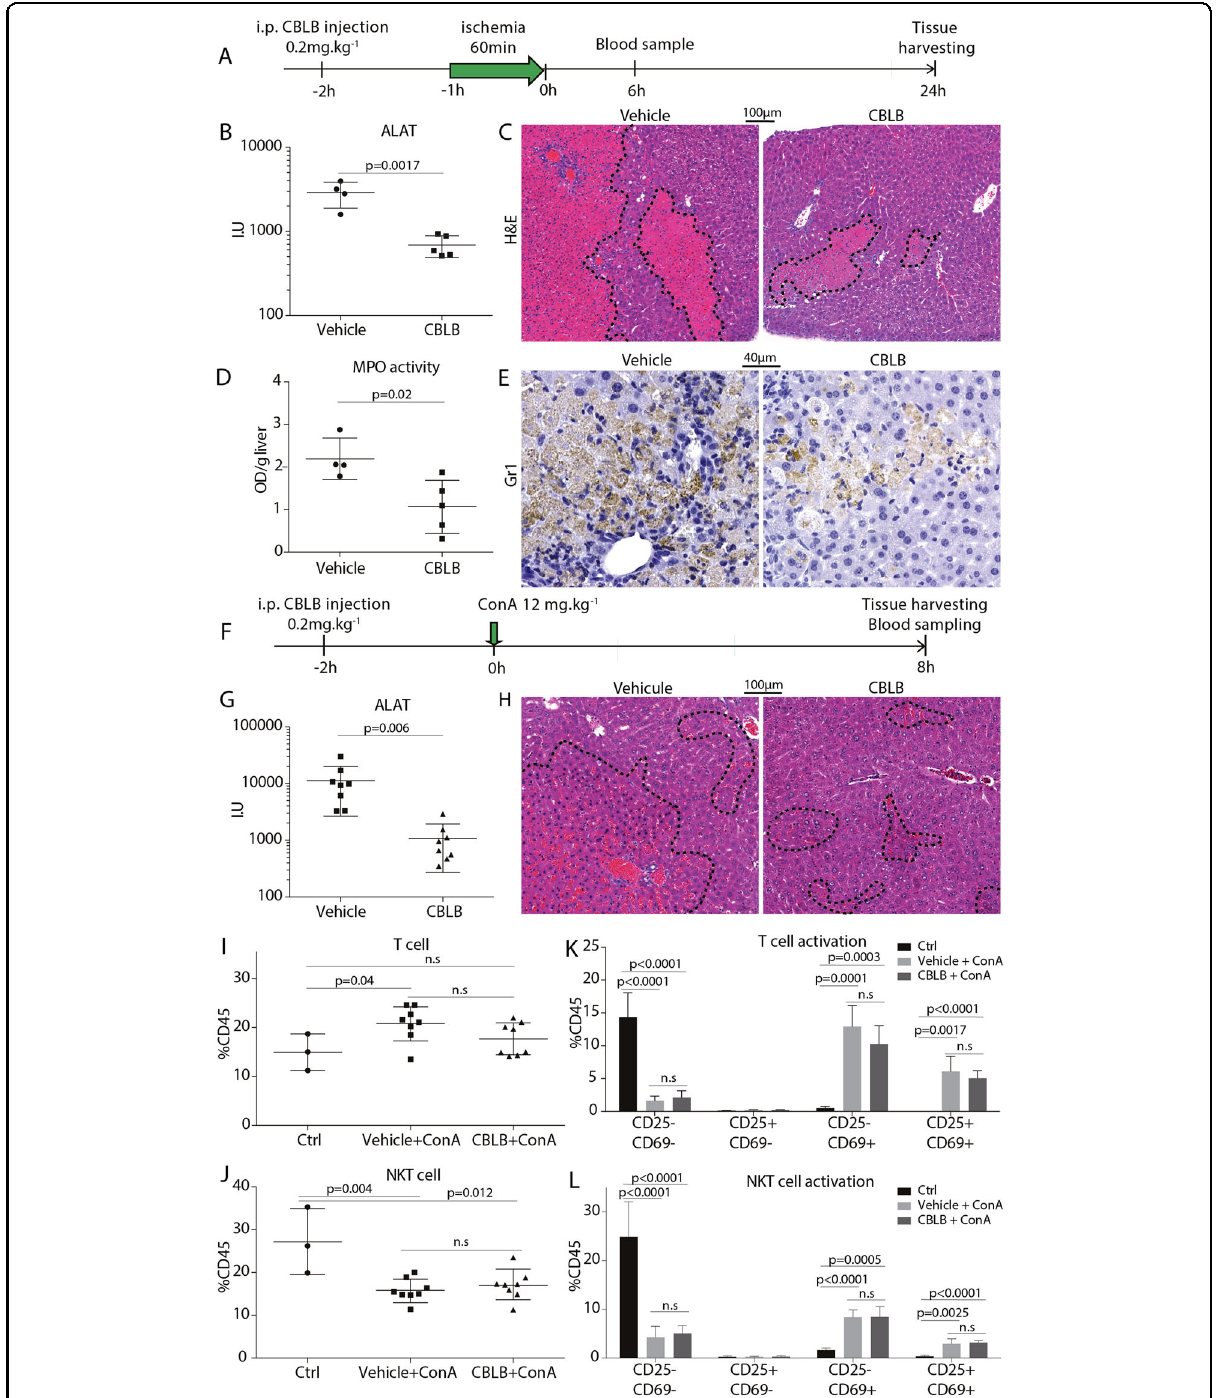
Fig. 1 CBLB decreases hepatic damage. A Experimental plan of ischemia-reperfusion study, vehicle n = 4, CBLB n = 5 mice. B Serum ALAT 6 h after reperfusion. C Representative H&E image of liver tissue 24 h post-reperfusion. D Tissue myeloperoxidase activity 24 h post-reperfusion. E Representative images of liver Gr1 immunohistochemistry 24 h post-ischemia-reperfusion. F Experimental plan of ConA model, vehicule n = 8, CBLB n = 8. G Serum ALAT 8 h after ConA challenge. H Representative H&E image of liver tissue 8 h following ConA injection. FACS analysis of I T cell and J NKT cells frequency represented as a percentage of CD45 + cells extracted from the liver 8 h ConA injection. FACS analysis of the activation frequency of K T cell and L NKT cell markers CD25 and CD69. Frequencies are represented as a percentage of CD45 + cells extracted from liver 8 h post-ConA